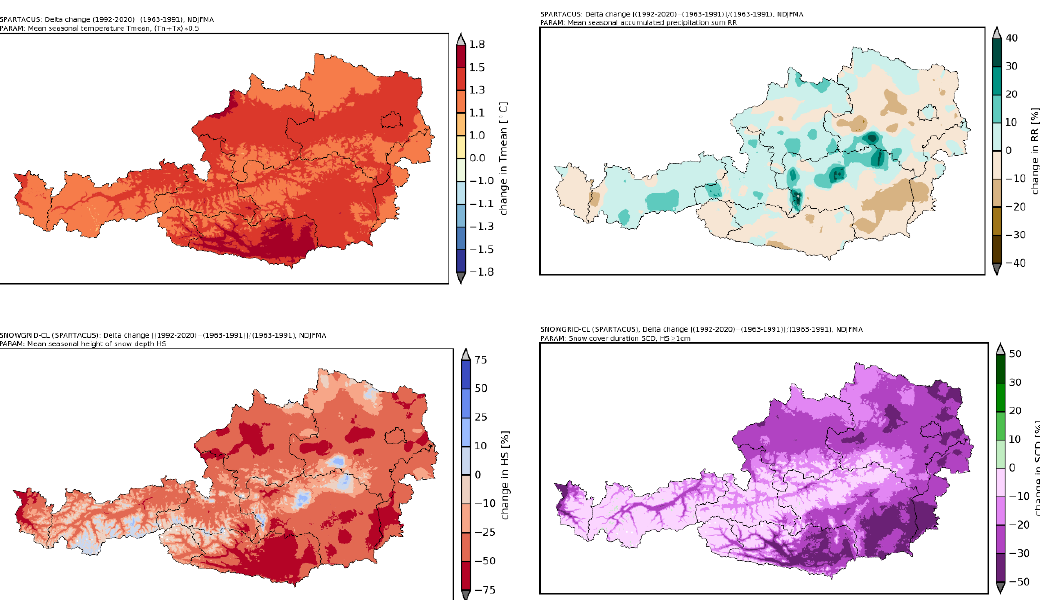
Figure 13. Observation-based gridded differences (1 × 1 km) of seasonal (NDJFMA) average air temperature ( top left panel ), precipitation sum ( top right panel ), snow depth HS ( lower left panel ), and snow cover duration (SCD) (HS ≥ 1 cm), ( lower right panel ) based on the two time slices 1992–2020 vs. 1963–1991.